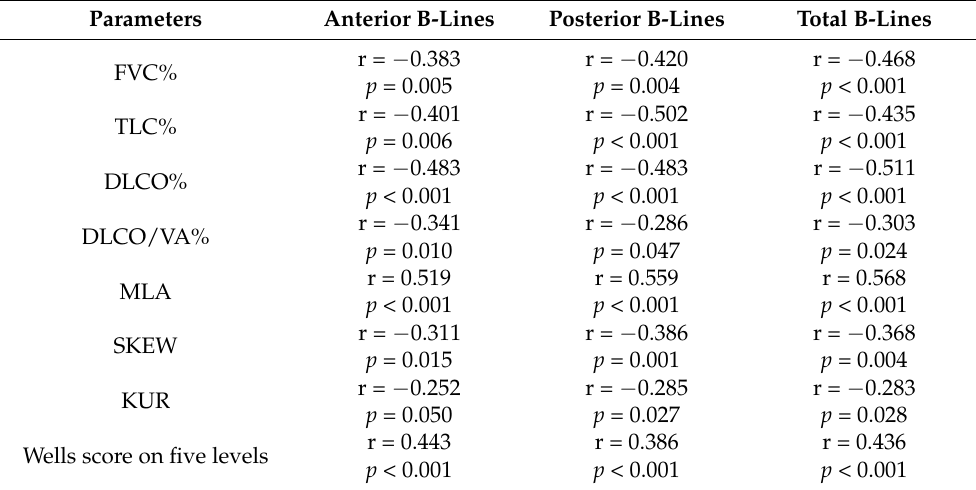
Table 3. Correlations between B-lines and pulmonary function tests, densitometry parameters and the visual